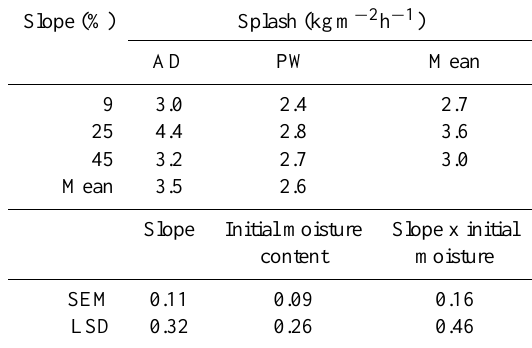
Table 6. Effect of the different combinations of antecedent moisture content and slope on splash detachment.